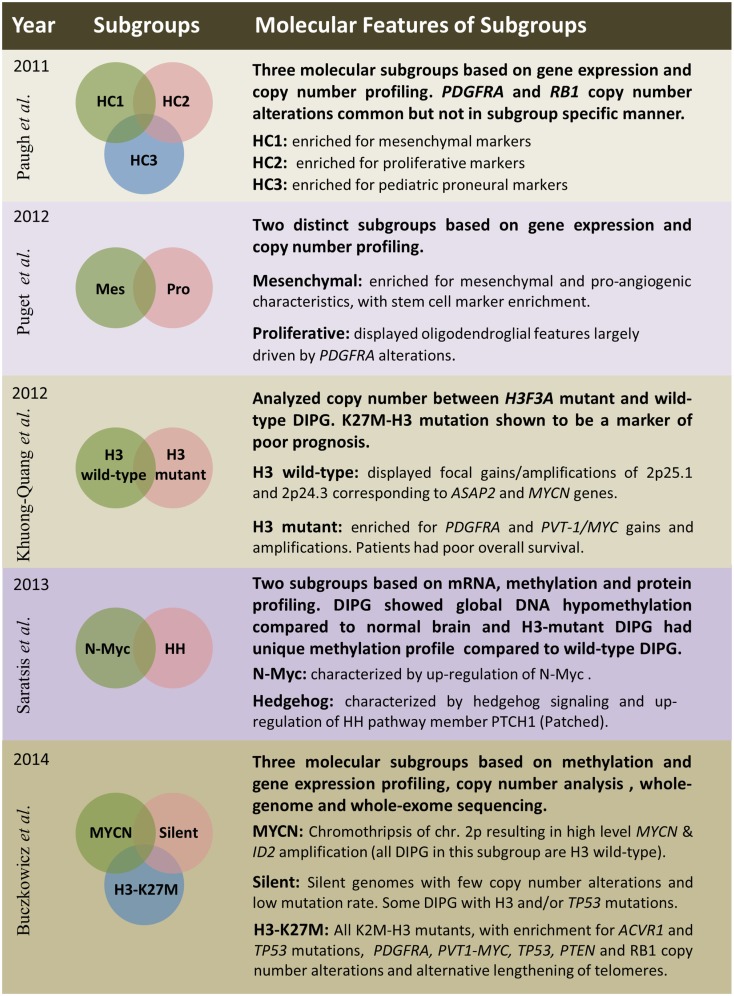
Summary of five publications between 2011 and 2014 outlining clinical and molecular features of diffuse intrinsic pontine gliomas based on various platforms and sample sizes; Paugh et al. (38), three subgroups – n = 27; Puget et al. (48), two subgroups – n = 23; Khuong-Quang et al. (3), two subgroups – n = 42; Saratsis et al. (85), two subgroups – n = 14; Buczkowicz et al. (40), three subgroups – n = 48.